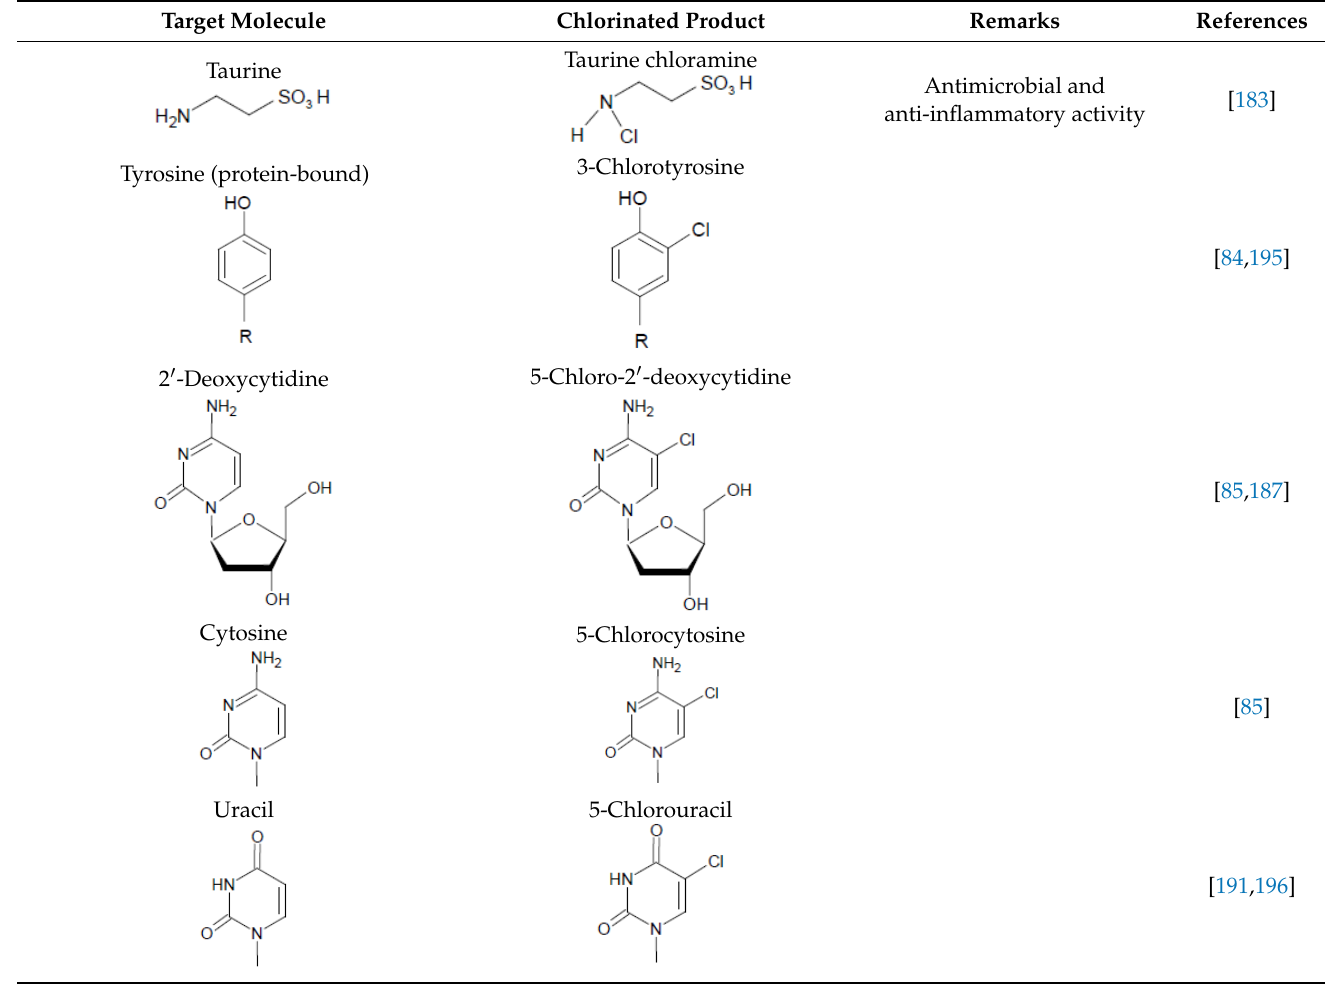
Table 2. Formation of MPO-mediated chlorinated products.